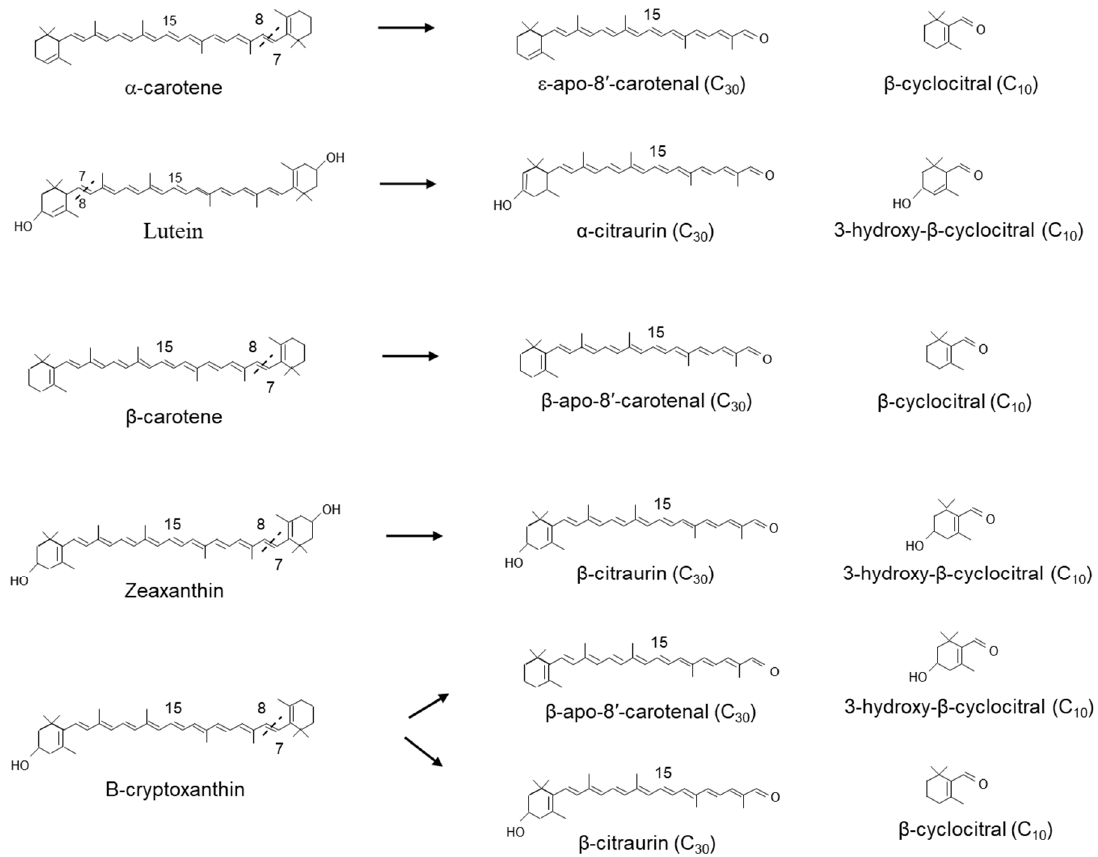
Figure 7. Scheme for the 7,8(7 ′ ,8 ′ ,) reactions catalysed by the recombinant carotenoid cleavage deoxygenase 4 in the plastid.